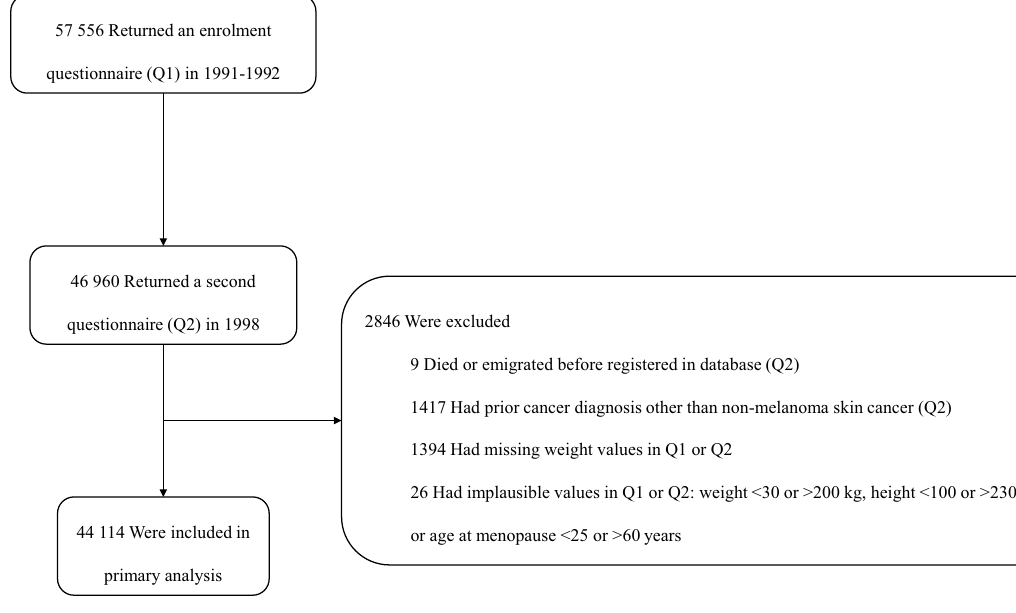
Figure 1. Flowchart of study